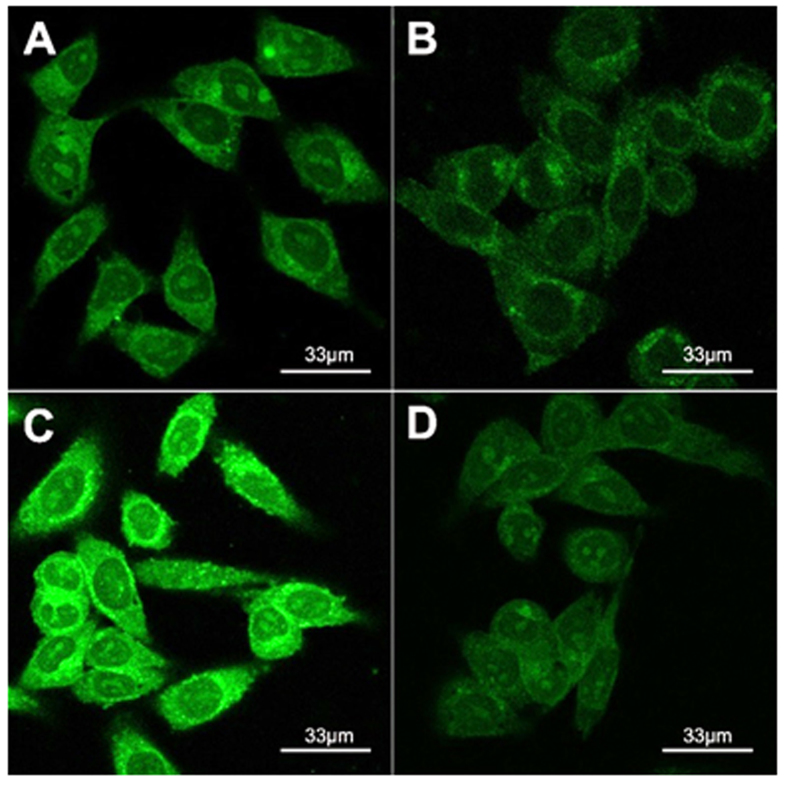
Confocal fluorescence microscopy images of HepG2 cells treated with25 μM of (A) Cur, (B) Nap-Cur, (C) GA-Cur, and (D) GA + GA-Cur for 4 hours.